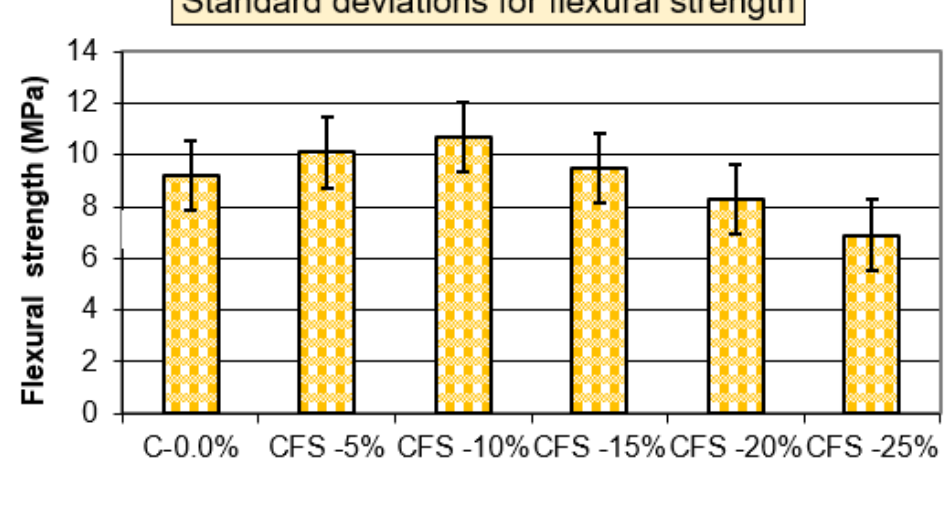
Figure 12. Standard deviations for compressive strength.